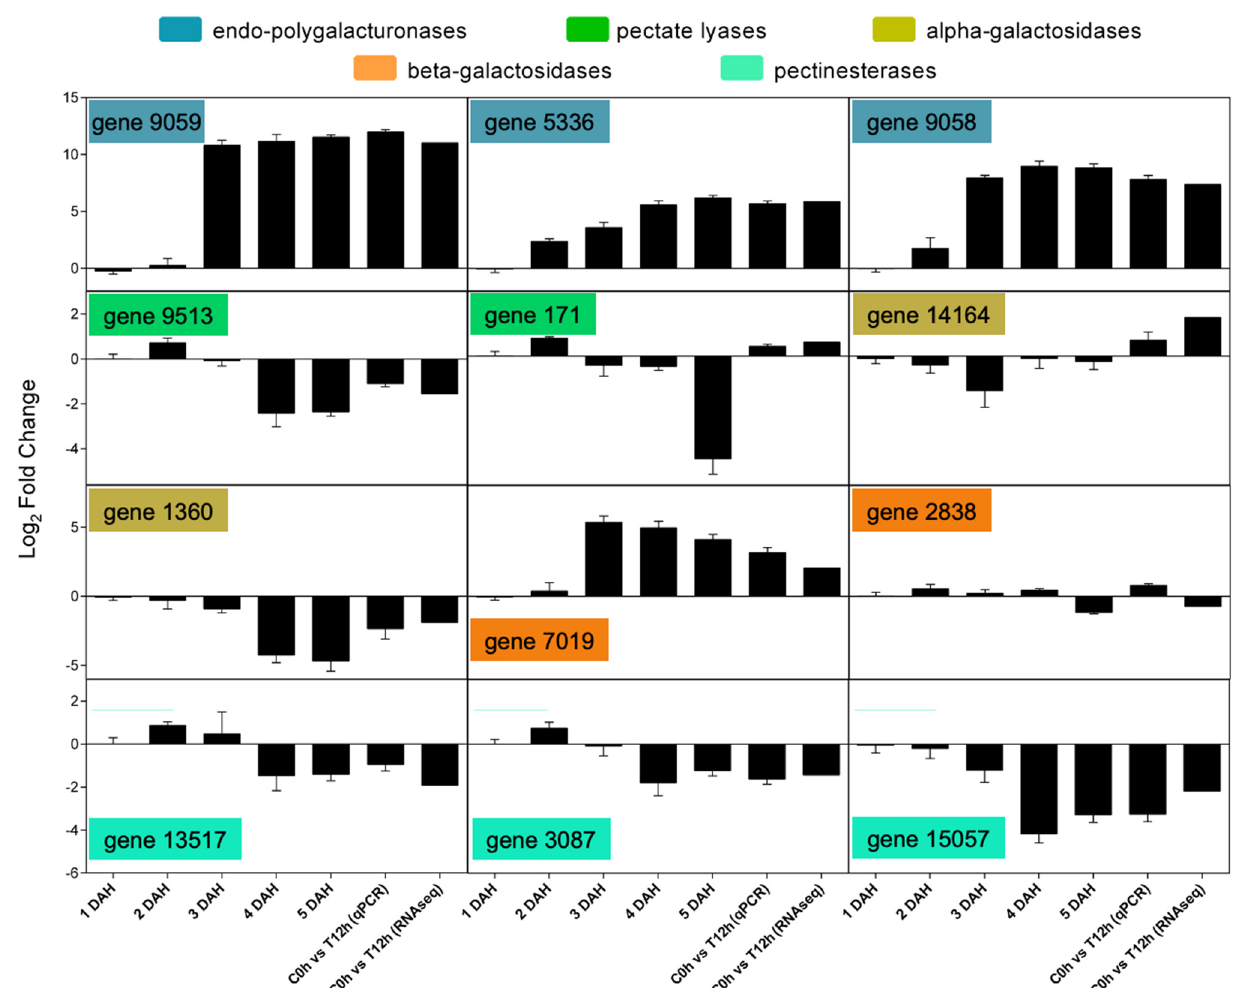
Figure 7. Confirmative gene expression experiment of cell-wall-related genes that were differentially expressed after ethylene-treatment of papaya fruit. The expression of differentially expressed genes between the control group (0 h) versus ethylene-treated fruit (12 h) was confirmed in the same sample (C0h X T12h) and in a ripening curve previously published with quantitative real-time PCR performed according to Prado et al. [22]. Gene ID is verified in Table S5. Samples are identified as C (control) or T (treated) followed by the time point and the day after harvested (DAH).